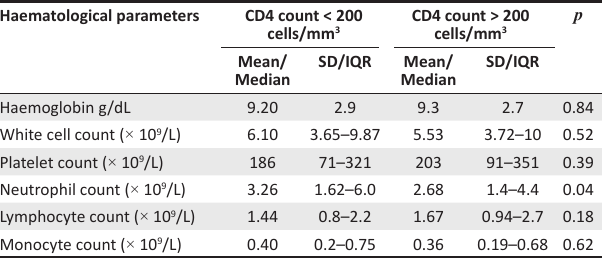
TABLE 5: Comparison of haematological parameters in patients with different CD4 counts (Mann–Whitney U test). Haematological parameters